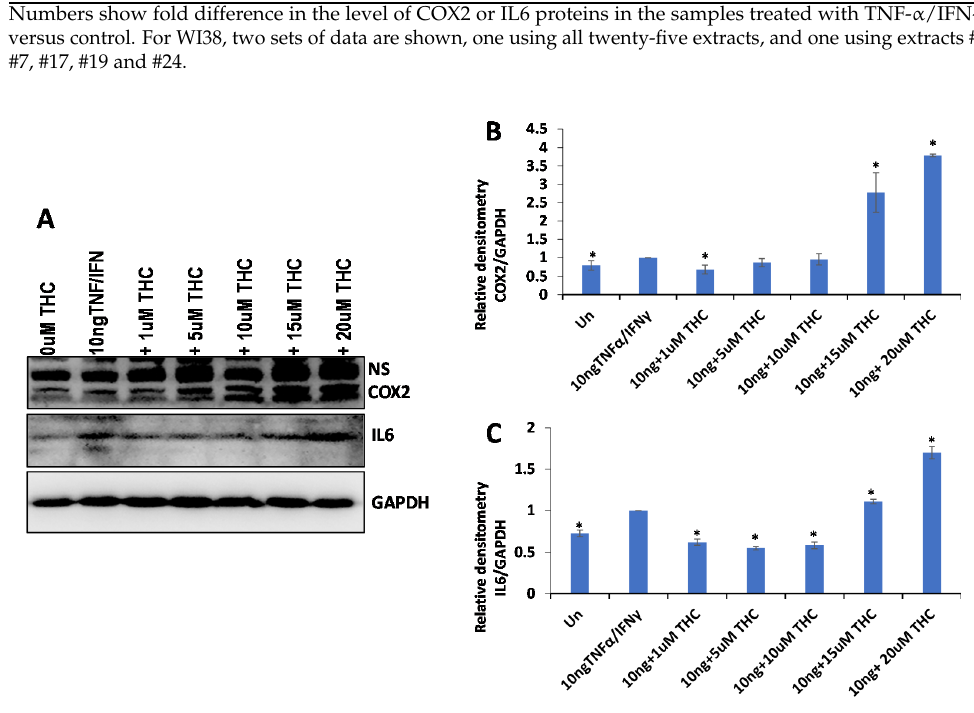
Figure 5. The effect of various concentrations of THC on the expression of COX2 and IL6 in WI38 cells treated with 10 ng/mL TNF- α /IFN- γ . ( A )—Western blot image of COX2, IL6 and GAPDH in response to DMSO, 10 ng/mL TNF- α /IFN- γ , or TNF- α /IFN- γ together with different concentrations of THC. ImageJ calculated the densitometry of COX2 ( B ) and IL6 ( C ) relative to GAPDH, calculated from 3 independent measurements, shown as averages with SE. Asterisks show significant difference from TNF- α /IFN- γ treatment ( p < 0.05).